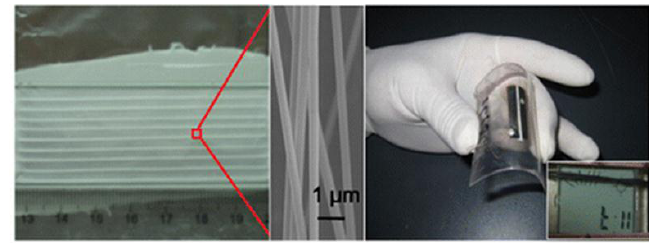
Figure 3. Nanocomposite generator using aligned PZT nanowires [69].